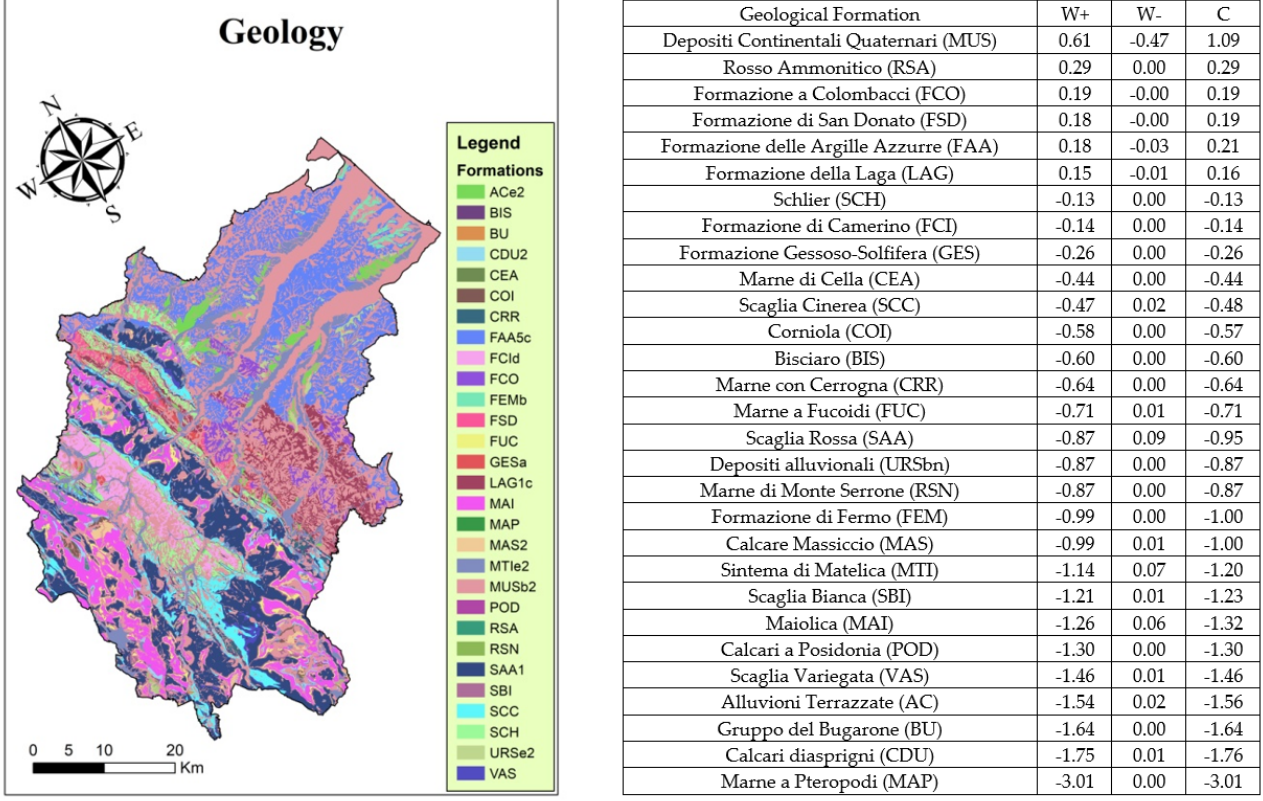
Figure 5. ( Left ) Geological map of Macerata Province; ( Right ) The weights calculated for the geology parameter, (W+) positive weights, (W-) negative weights, (C) contrast; formations are described by the CARG PROJECT [36].